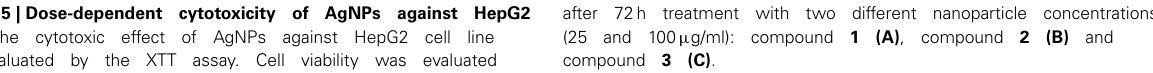
after 72h treatment with two different nanoparticle concentrations (25 and 100 μ g/ml): compound 1 (A) , compound 2 (B) and compound 3 (C)